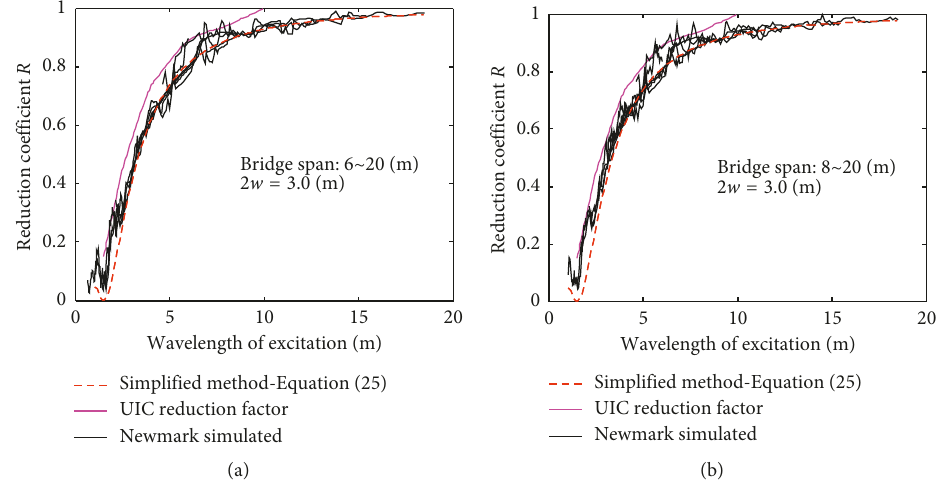
Figure 15: Maximum acceleration of the eight example bridges. (a) Span span 8 ∼ 12m (VBI model), and (d) span (cid:29)